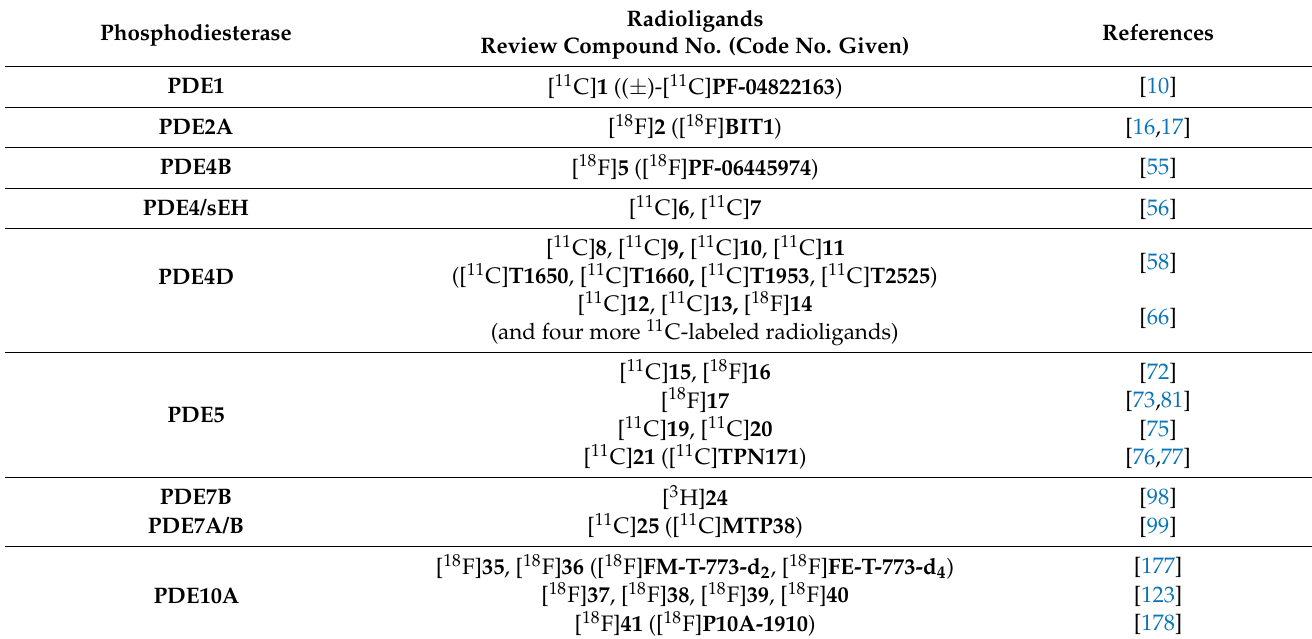
Table 1. Update of novel radioligands for PET imaging of the PDEs 1, 2A, 4 (B, D), 5, 7 (A,B), and 10A since 2016. Radioligands Phosphodiesterase Review Compound No. (Code No.